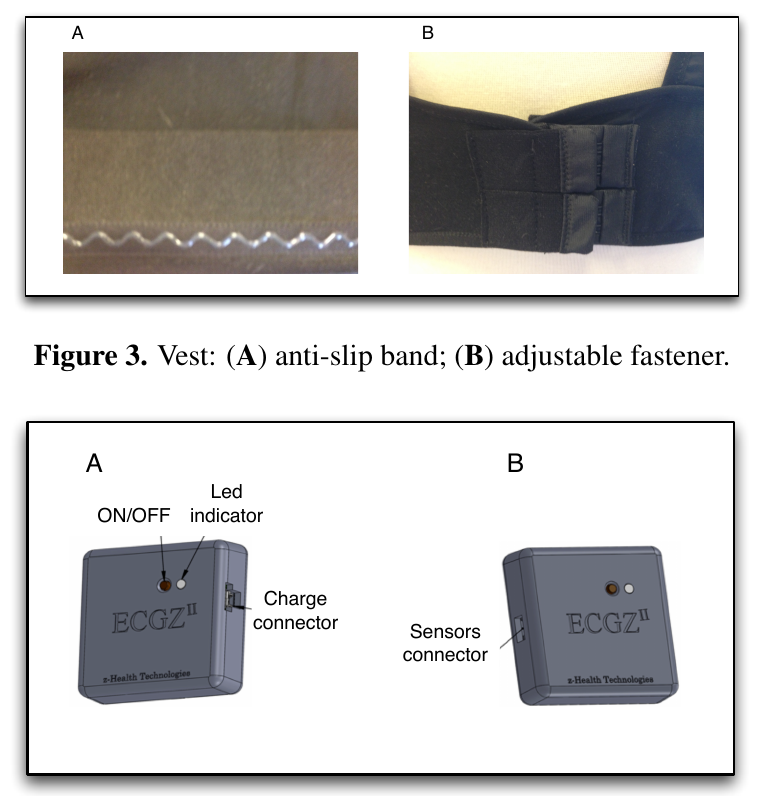
Figure 4. ECGZ2 device design: ( A ) left device view; ( B ) right device